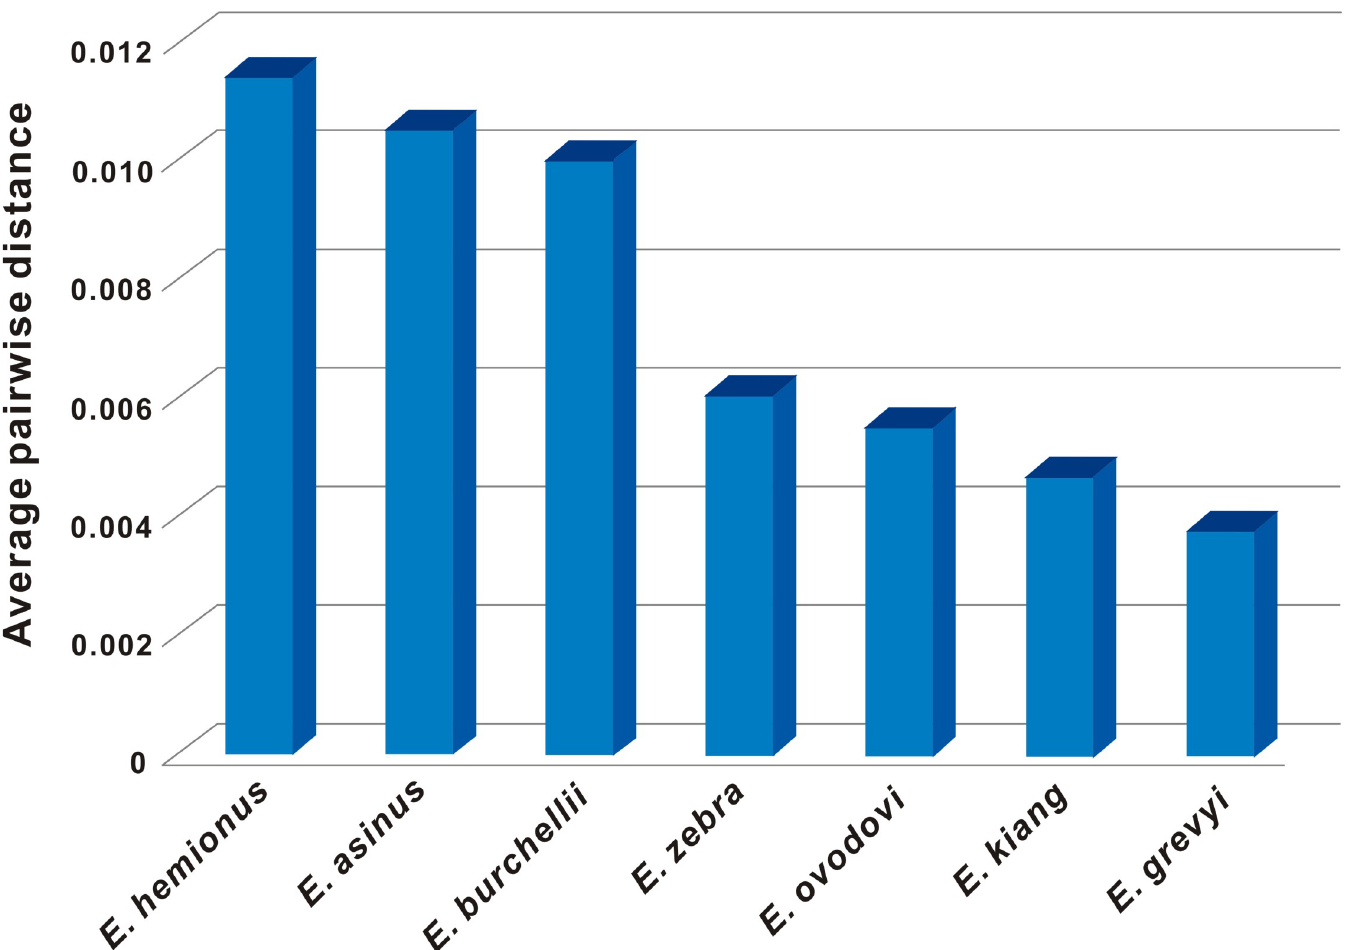
Fig 4. Average pairwise mitochondrial distances within non-caballine equid